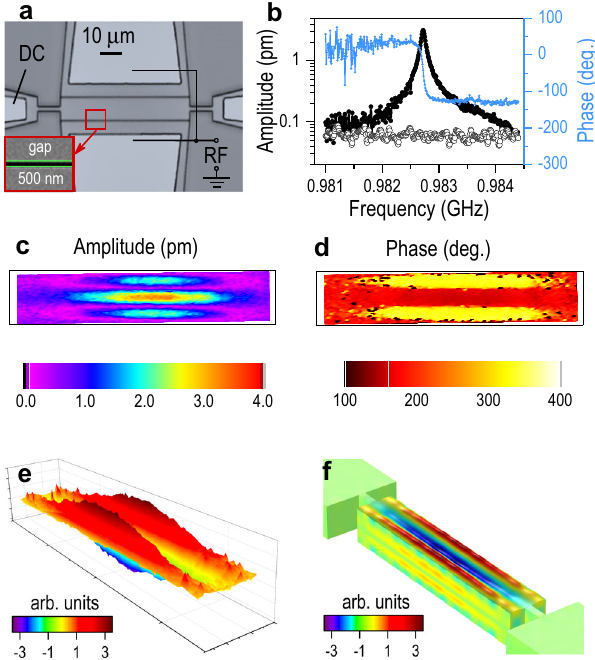
Fig. 3 Imaging high-Q micromechanical vibrations. a Optical micrograph of the BAR with a schematic drawing of the applied DC and RF power. b Frequency response of the third width mode where the displacement amplitude and phase are shown in black and blue, respectively, for a DC bias of 20 V and an RF power of 10 mW. The displacement amplitude shown with hollow circles is for a DC bias of 20 V and the RF drive signal disconnected. c , d Mapping the BAR vertical vibration amplitude and phase at 0.9827 GHz. The black lines represent the outer dimensions of the BAR, 11.5 μ m × 65 μ m. Combining amplitude and phase results in a 3D mapping of the mechanical resonance, as shown in ( e ). It matches with the resonance mode shape calculated by fi nite-element analysis for the third width-extensional mode shown in ( f